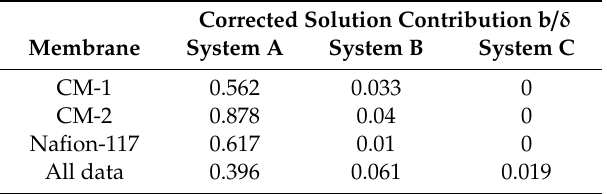
Table 5. Corrected solution contribution b / δ from experiments by Nouri et al. [15].